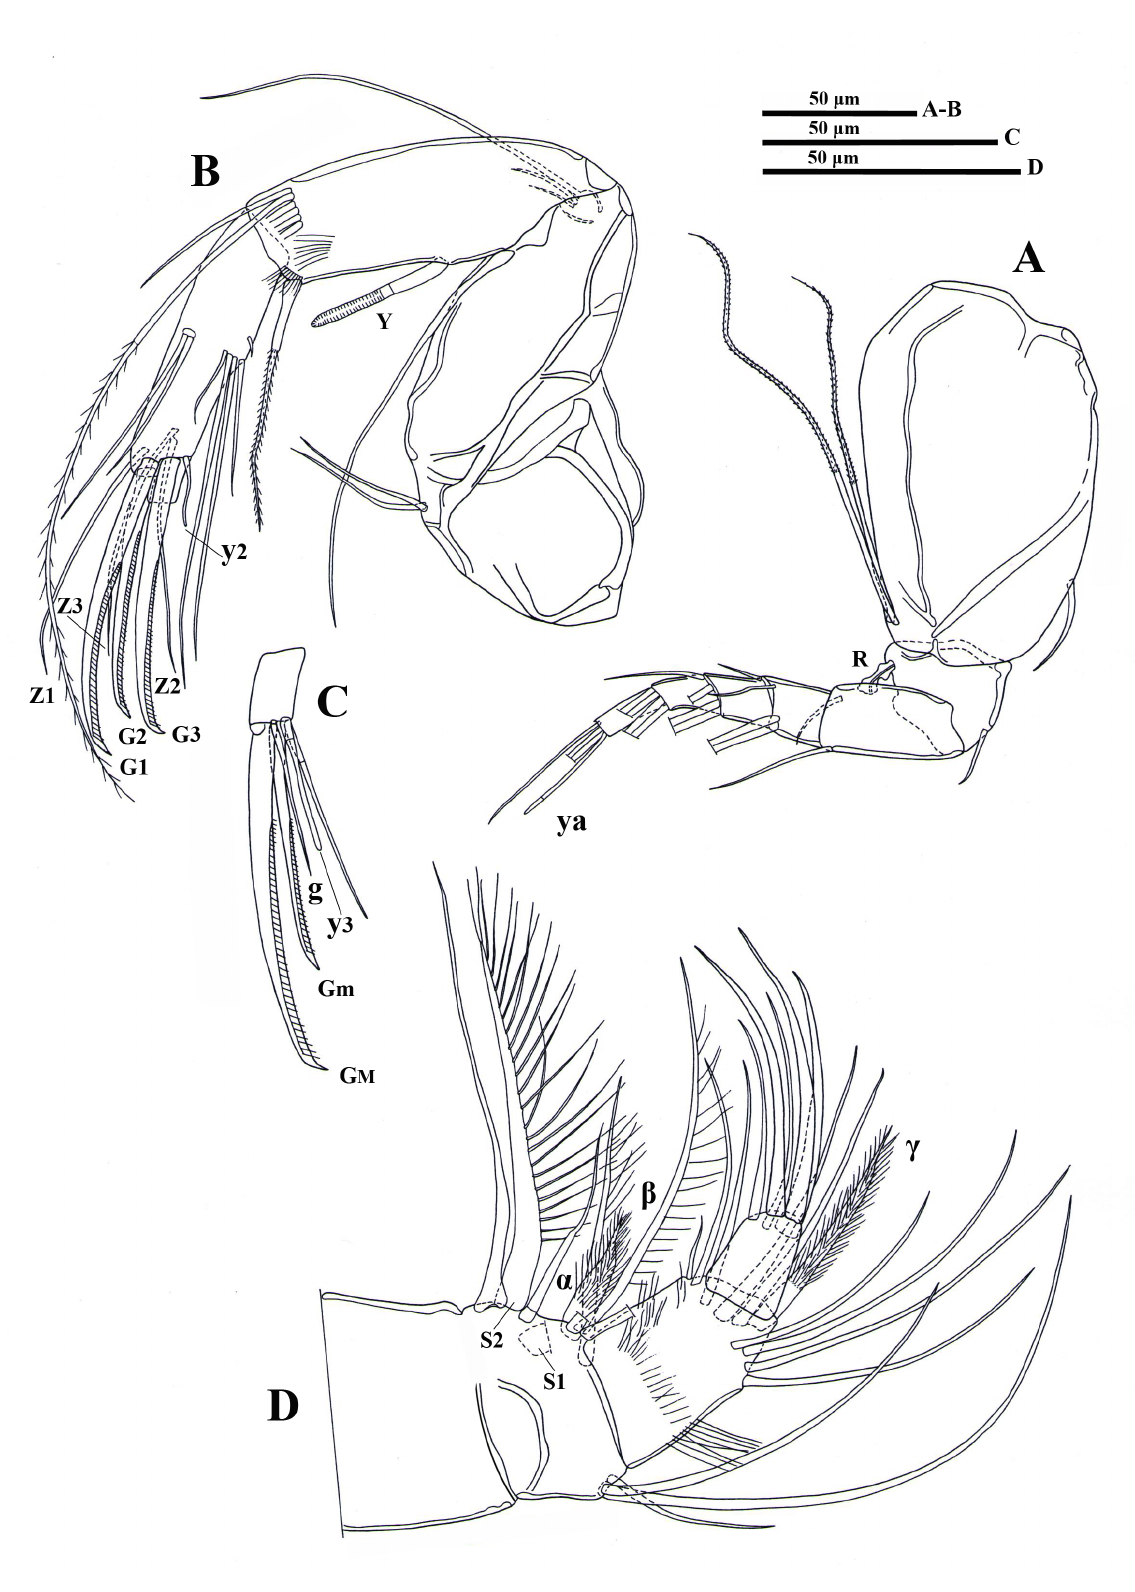
Fig. 3. Pseudostrandesia ratchaburiensis sp. nov. Paratype, ♀ (MSU-ZOC.292). A . A1. B . A2. C . Terminal segment of A2. D . Md-palp. R–Rome